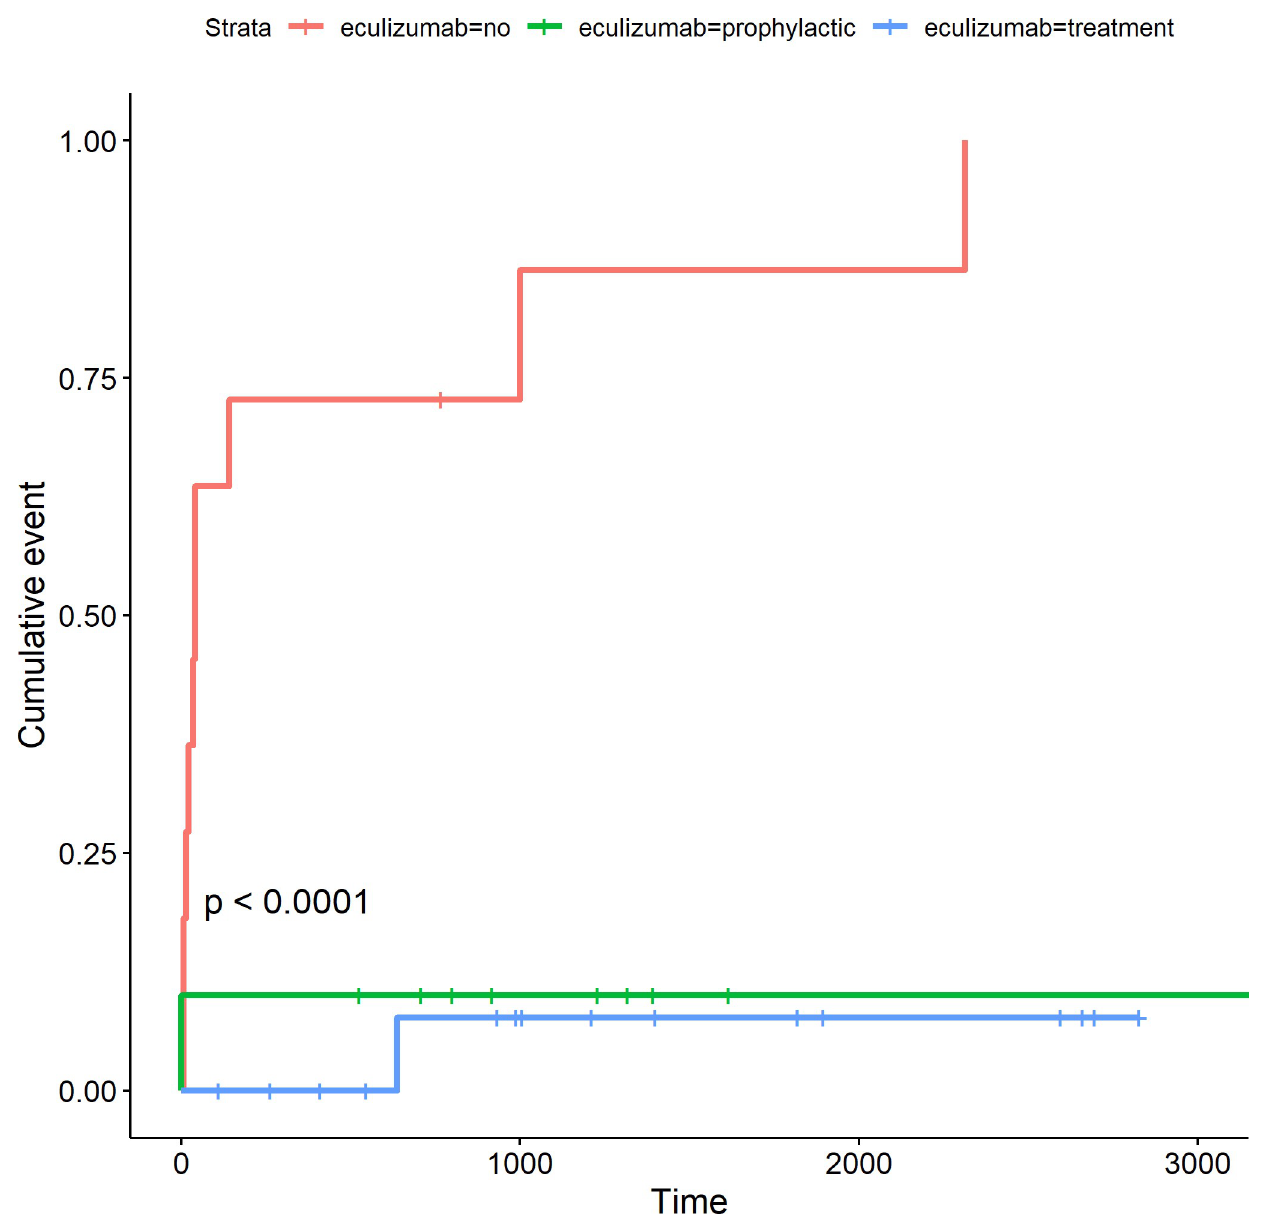
Fig 2. Cumulative incidence of TMA graft loss (days) in the Brazilian aHUS cohort patients divided by groups: Not received eculizumab (red), prophylactic eculizumab (green), and eculizumab treatment (blue).